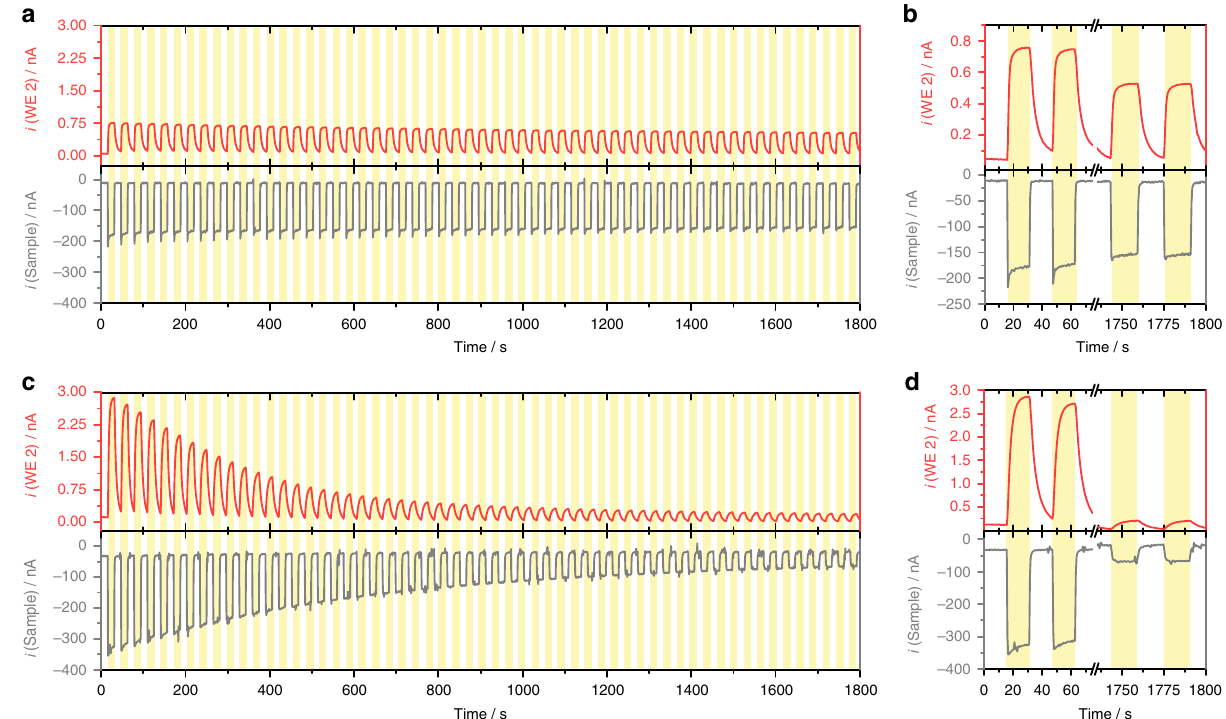
Fig. 4 Long-term stability of the photocurrent at varying O 2 concentrations. Simultaneous photochronoamperometric responses and collection of H 2 O 2 recorded at a PS1/Os-complex-modi fi ed redox polymer photocathode a , b air-equilibrated solution and c , d O 2 -saturated solution. The sample was polarized at 0 mV, while the Pt disk microelectrode was polarized at + 600 mV vs. Ag/AgCl/3 M KCl (WE 2). Electrolyte: 3 mM MV 2 + in 0.2 M citrate- phosphate buffer, pH 7.0. Tip-to-sample distance: 10 μ m. The sample was locally irradiated (white light, 280 mW cm − 2 ) through the sheath of the positioned microelectrode for periods of 15 s as indicated by the yellow shaded regions in the graphs. A comparison of the initially recorded currents with the response obtained at the end of the experiment is given in graphs b , d (note the different current scales for b in comparison with a